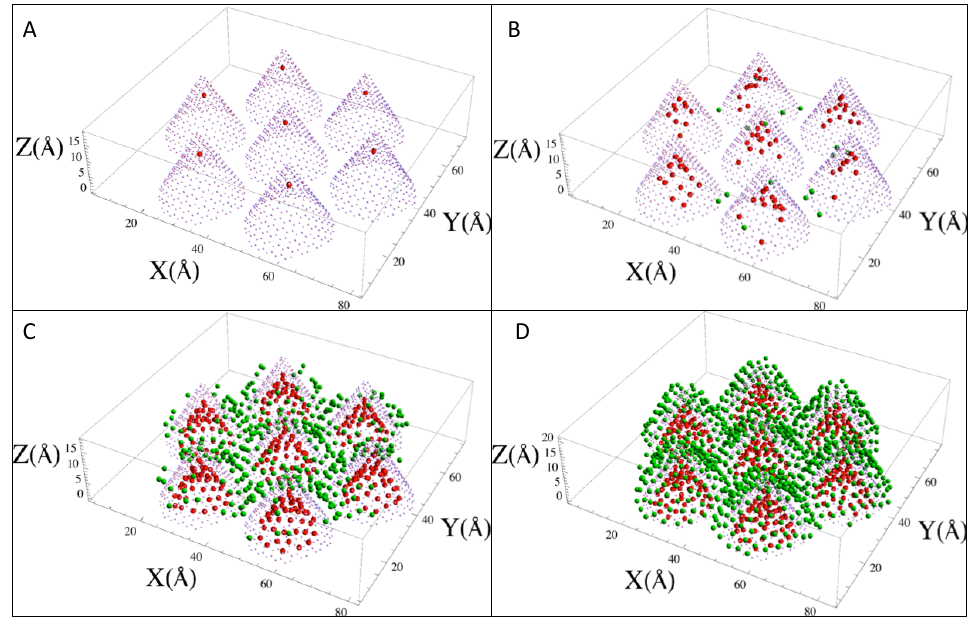
Figure 3. Sample configurations (at T, P conditions, indicated by the labels A to D in Figure 2 showing Ne atoms inside the cones (red) or outside